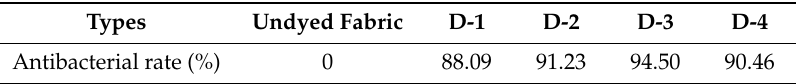
Table 6. The antibacterial rates of dyed wool/acrylic blended fabrics.